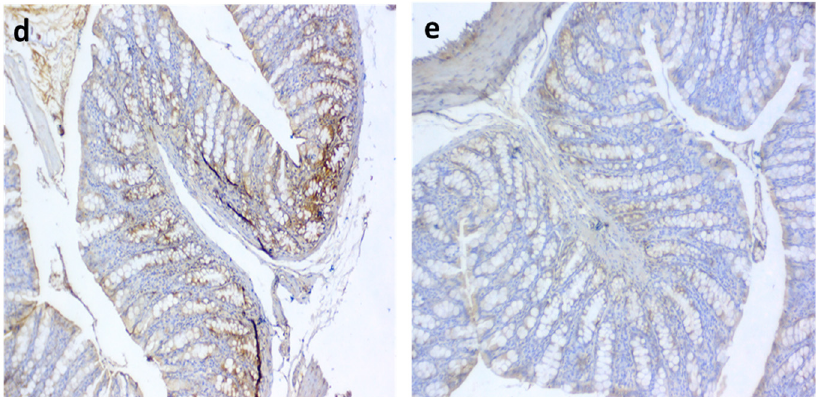
Figure 8. Photomicrographs of immunoexpression for iNOS in colon sections showing ( a ) negative control with no positive reaction; ( b ) positive control group with intense immunopositive reactions of anti iNOS in DSS group; ( c ) moderate number of immunopositive cells in QT-NPsI group; ( d ) weak stained cells in few numbers in colon epithelium in QT-NPsII group; ( e ) no immunoreactive cells in QT-NPsIII group. IHC counterstaining with Mayer’s hematoxylin. Scale bar 100 μ m.